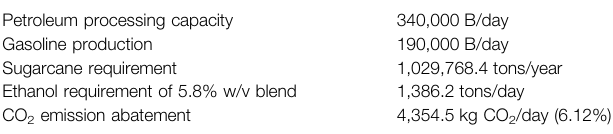
TABLE 5 | Gasoline capacity, required sugarcane and ethanol, and CO 2 abatement emissions for Dos Bocas re fi nery in Tabasco State. Petroleum processing capacity 340,000 B/day Gasoline